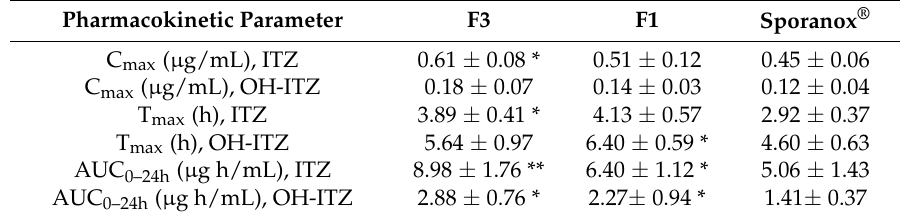
Table 3. Pharmacokinetic parameters of ITZ and OH-ITZ after oral administration of the optimized formulation (F3), formulation of ITZ-HPMCAS (F1), and marketed product (Sporanox ® ) at a dose of 100 mg in beagle dogs (Mean ± S.D., n =